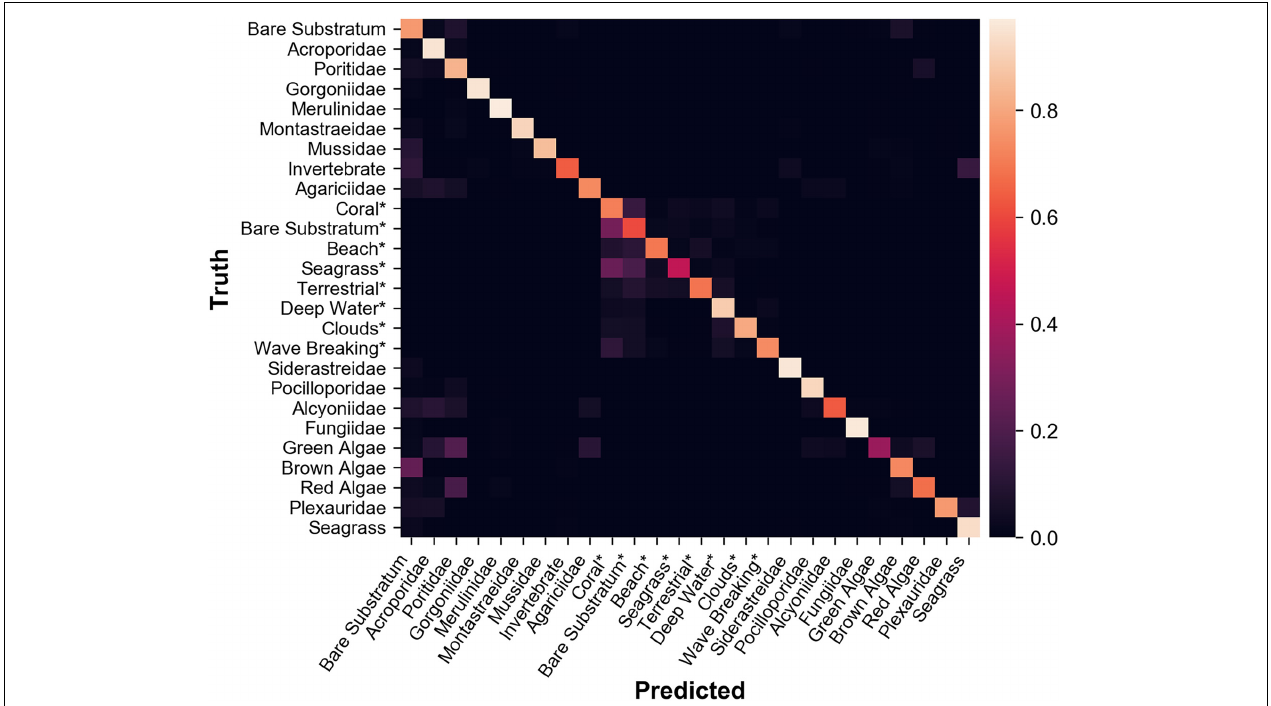
FIGURE 7 | Normalized confusion matrix of each class label, generated using user training data. Class labels with an asterisk indicate that the class label is used purely in satellite classifications. The average recall over all class labels is ∼ 78%.